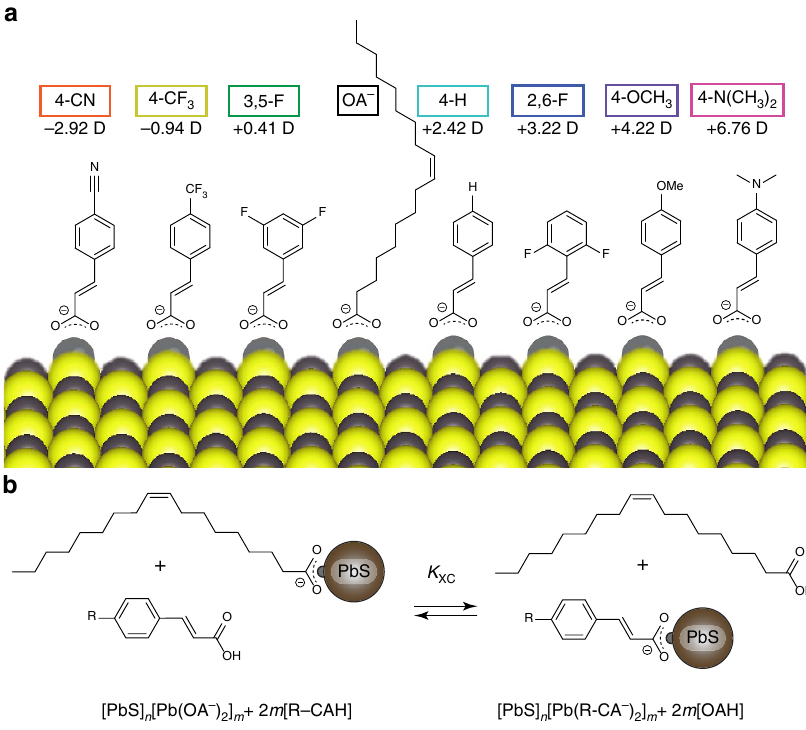
Figure 1 | The model ligand/QD system utilized in this study. ( a ) Chemical structures, computed vacuum electronic dipoles and labels used throughout this work of the molecules in our ligand library. 4-CN-CA (cid:2) ¼ 4-cyanocinnamate; 4-CF 3 -CA (cid:2) ¼ 4-trifluoromethylcinnamate; 3,5-F-CA (cid:2) ¼ 3,5-difluorocinnamate; 4-H-CA (cid:2) ¼ cinnamate; 2,6-F-CA (cid:2) ¼ 2,6-difluorocinnamate; 4-OCH 3 -CA (cid:2) ¼ 4-methoxycinnamate; 4-N(CH 3 ) 2 -CA (cid:2) ¼ 4-dimethylaminocinnamate. OA (cid:2) ¼ oleate. ( b ) The X-type ligand exchange in which surface bound oleate is displaced by functionalized cinnamic acid molecules.